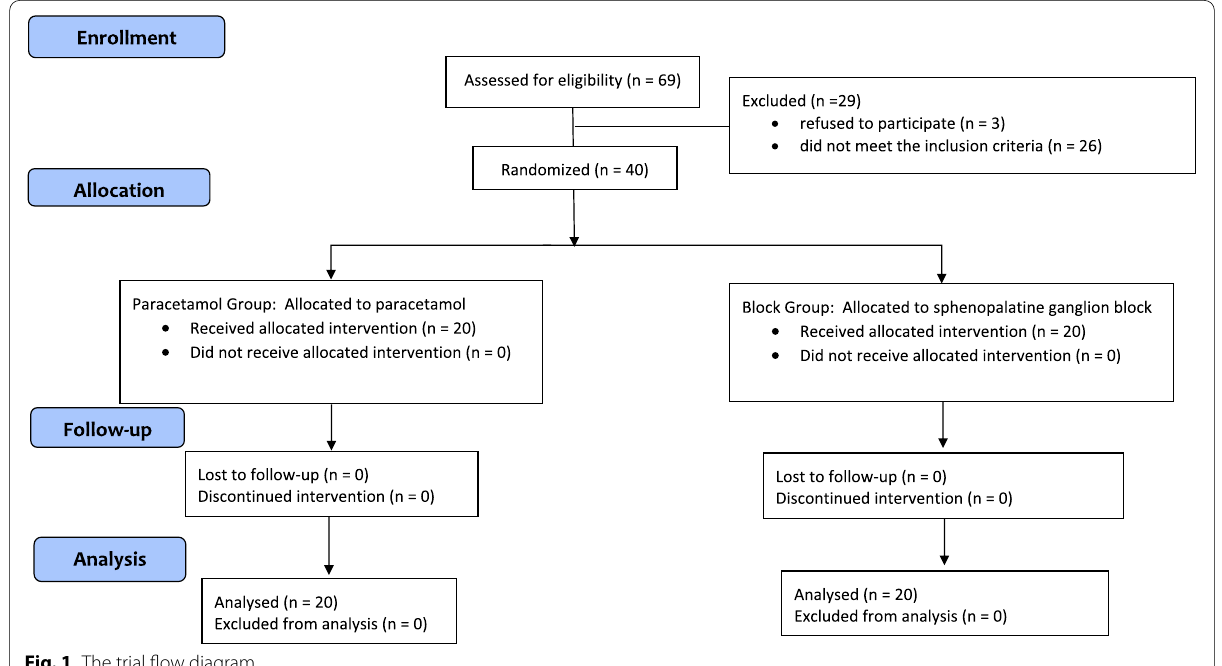
Fig. 1 The trial flow diagram